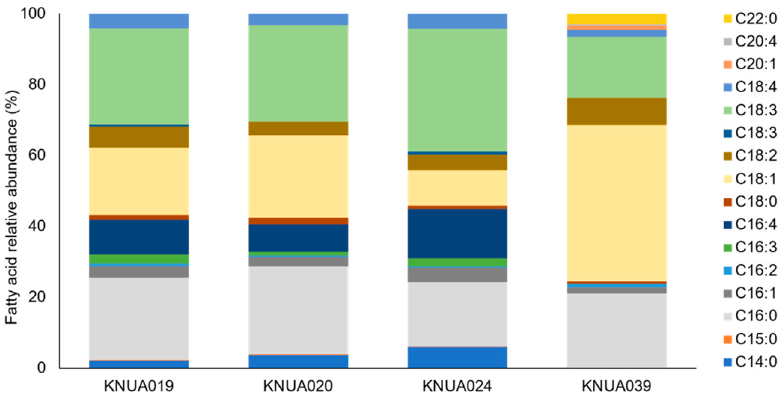
Figure 5. Fatty acid methyl-ester composition of the microalgal biomass in treated, primary settled wastewater.